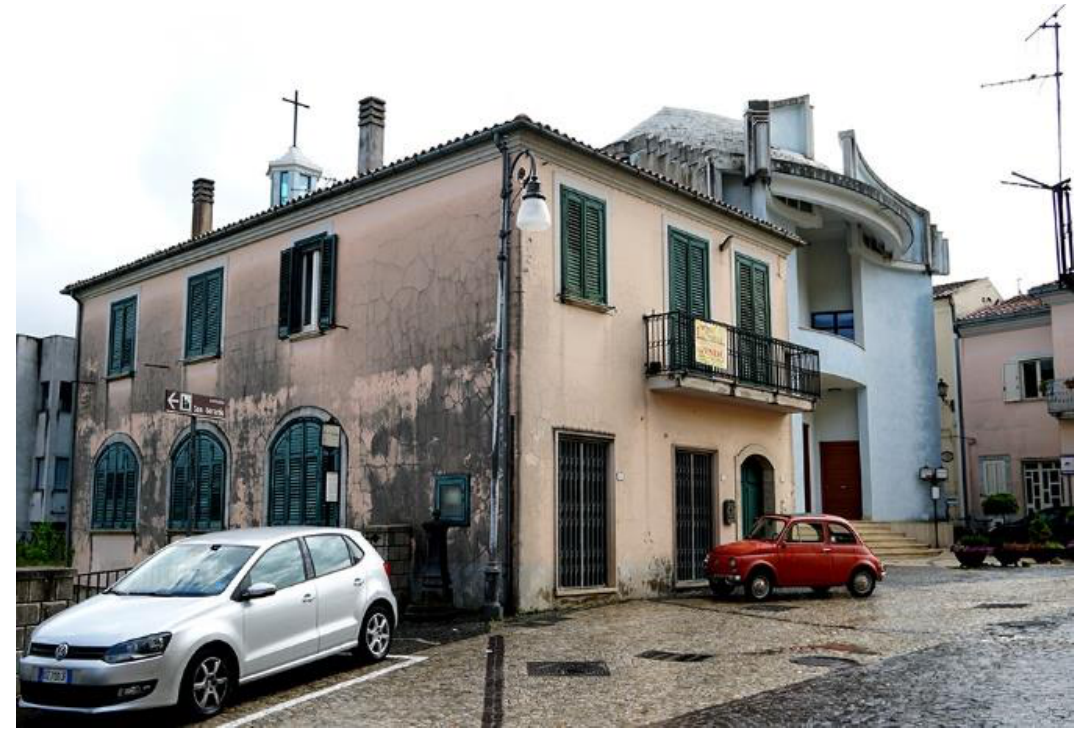
Figure 46. Caposele: the historical center with the new buildings reconstructed taking into account the original urban design (photos by [35,36]).